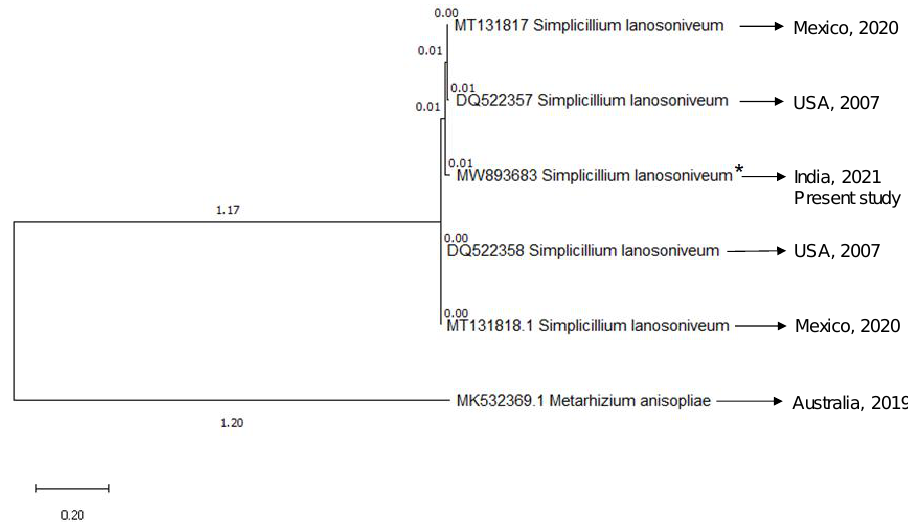
Figure 2. Phylogenetic tree based on maximum-likelihood analysis of combined ITS, b-tubulin and EF-1a sequences data. The sequence MW893683 (*) is the sequence generated in the present study and it branched with the retrieved sequences of S. lanosoniveum . Metarhizium anisopliae (MK532369.1) represented the